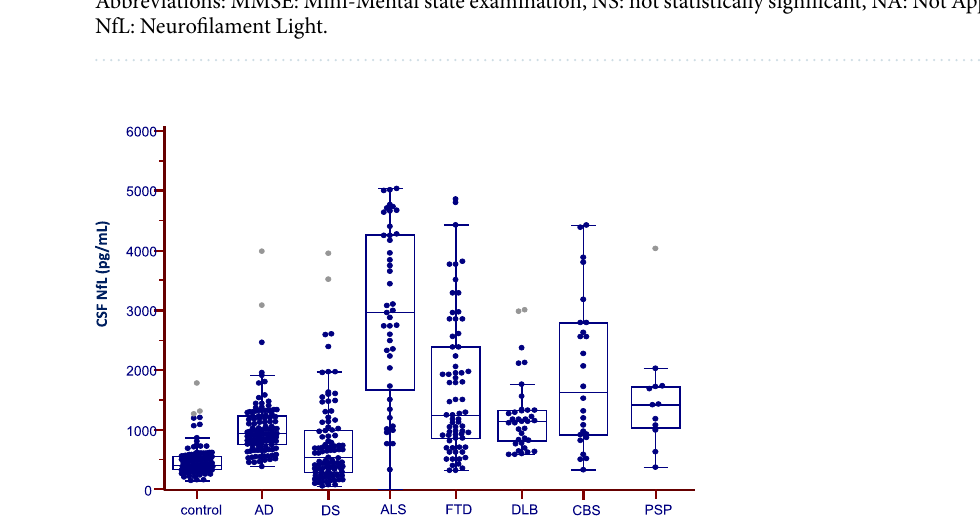
Figure 1. CSF Neurofilament Light (NfL) protein levels in the SPIN cohort. Box and whisker plots of the median concentrations of CSF NfL in control participants and patients with Alzheimer Disease (AD), Down Syndrome (DS), Dementia with Lewy Bodies (DLB), Amyotrophic Lateral Sclerosis (ALS), Frontotemporal Dementia (FTD), Corticobasal Syndrome (CBS) and Progressive Supranuclear Palsy (PSP). The central black lines show the median values, regions above and below these lines show the upper and lower quartiles, respectively. Outliers (indicated with grey circles) are defined as a value that is larger than the upper quartile plus three times the interquartile